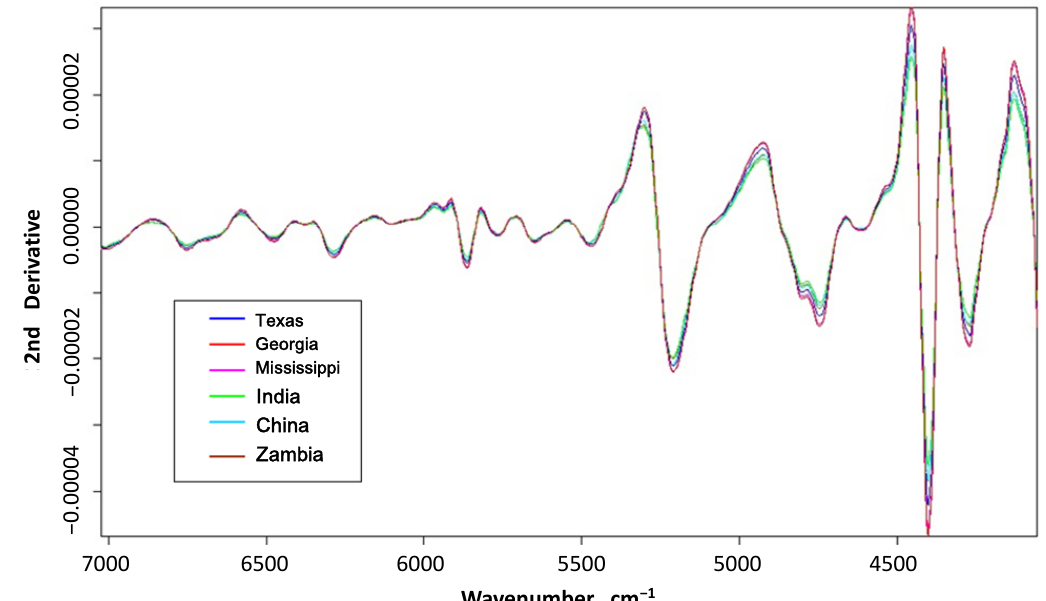
Figure 2. Representative NIR second derivative spectra of international and U.S.